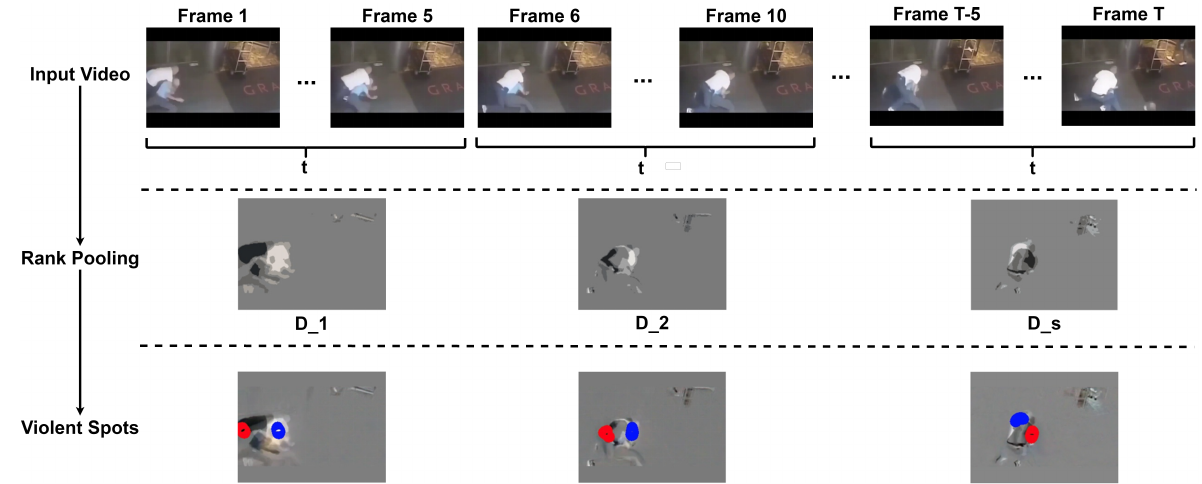
Figure 3. Violent Spots. First, an input video is broken into s clips of duration τ (first row). Each seg- ment is summarized into a dynamic image to highlight motion regions in the segment (second row). The third row shows violent spots in the dynamic image to obtain regions with fast movement. The brightest spots are in blue, while the darkest spots are in red.